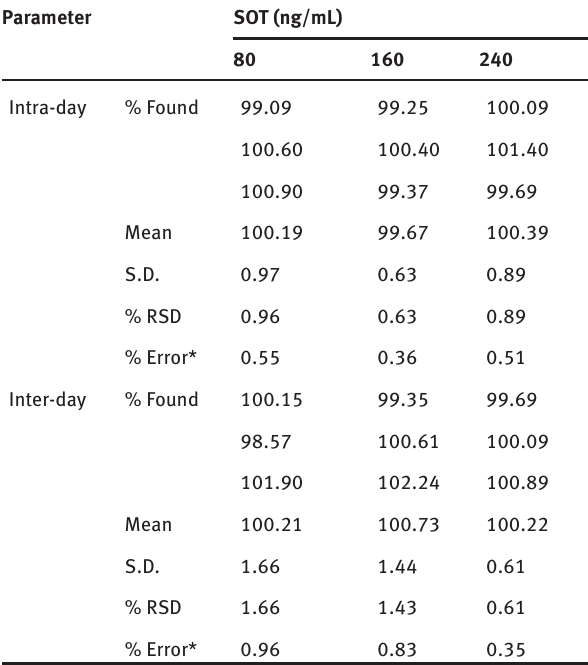
Table 3: Precision data for the determination of SOT by the proposed method.